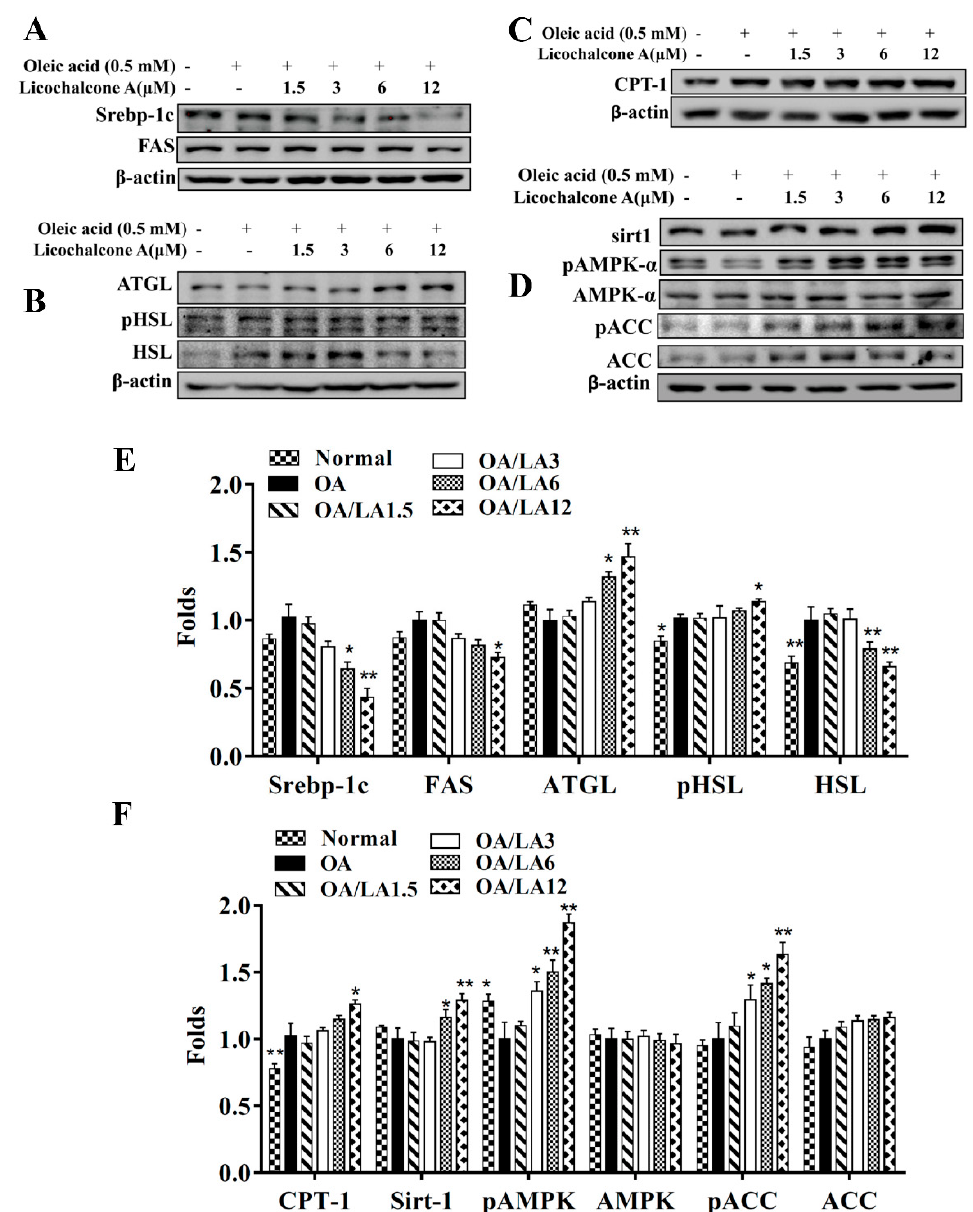
Figure 9. E ff ects of licochalcone A (LA) on lipid metabolism in HepG2cells. HepG2 cells were treated with 0.5 mM oleic acid (OA) for 48 h to induce lipid accumulation in hepatocytes, followed by treatment with licochalcone A (1.5–12 µ M) for 24 h. ( A ) The expression of transcription factors associated with adipogenesis and lipogenesis proteins, ( B ) lipolysis, ( C ) β -oxidation, and ( D ) the AMPK / Sirt-1 pathway were detected by Western blot. ( E,F ) The fold expression levels were measured relative to the expression of β -actin. Three independent experiments were analyzed, and data are presented as the mean ± SEM. * p < 0.05, ** p < 0.01 compared to oleic acid-induced HepG2 cells.